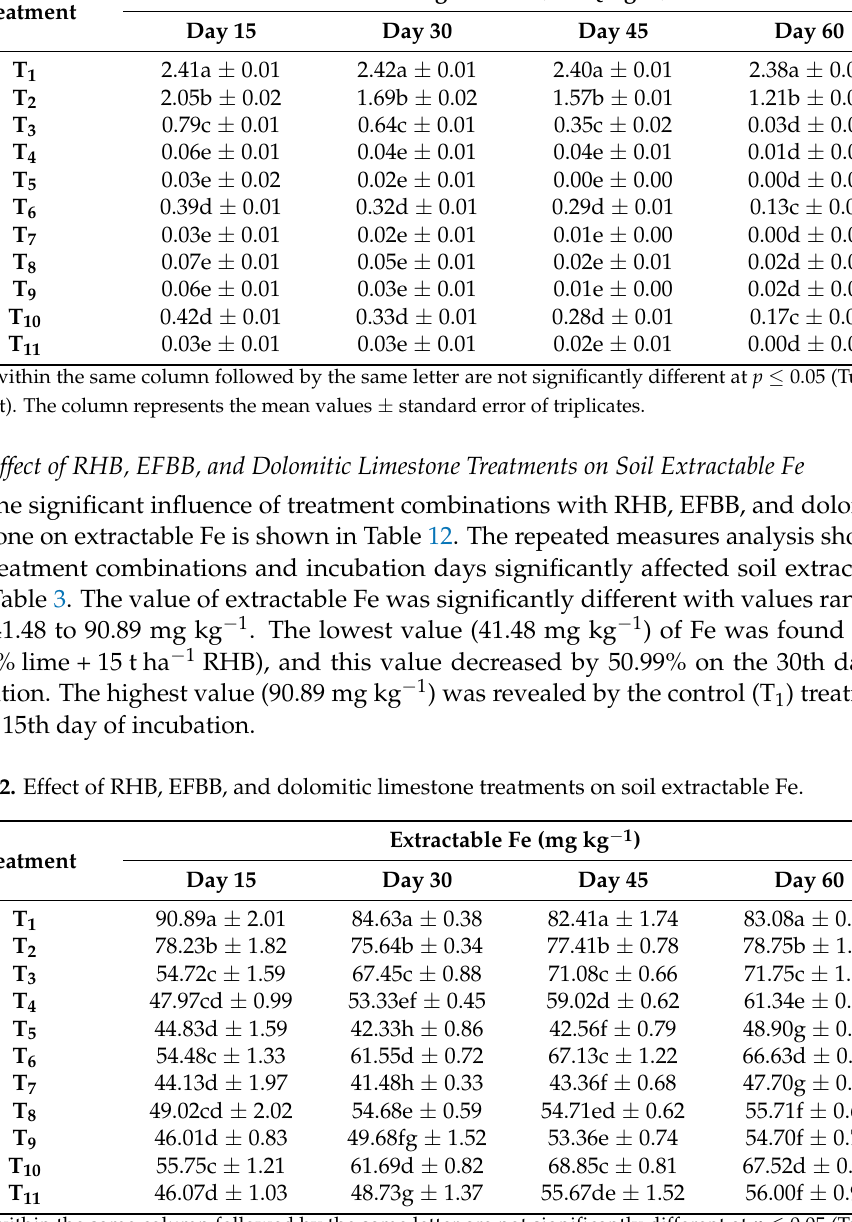
Table 11. Effect of RHB, EFBB, and dolomitic limestone treatments on soil exchangeable Al. Treatment